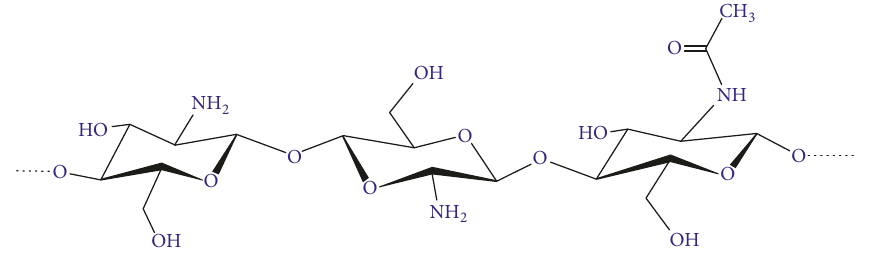
Figure 1: Structure of chitosan